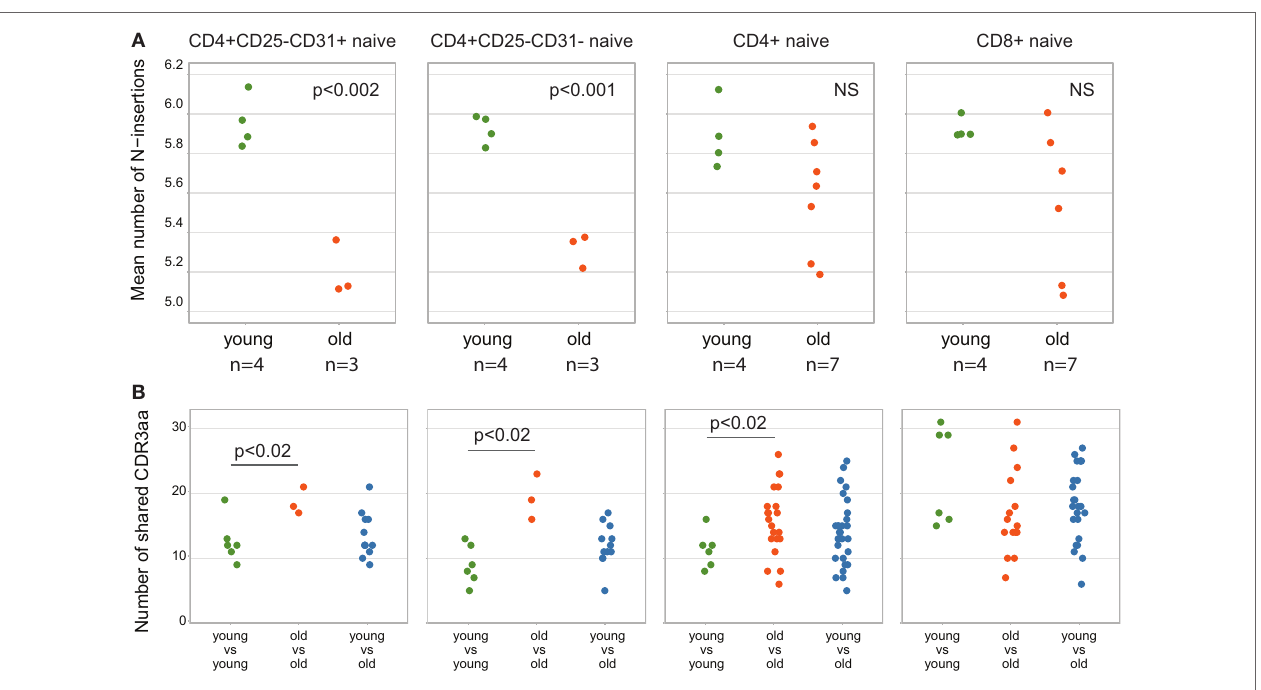
FigUre 7 | Relative publicity of naïve T cell T-cell receptor (TCR) beta repertoires. (a) Mean number of N-insertions among top-3,000 clonotypes from each sample. Unweighted (per clonotype), only for the clonotypes where TRBD segment borders were identified. (b) Repertoire overlaps calculated as the number of TCR beta amino acid CDR3 clonotypes shared between the top-3,000 clonotype repertoires for each pair of individuals. Each dot represents the number of clonotypes shared between a pair of samples. Welch Two Sample t -test p -values are